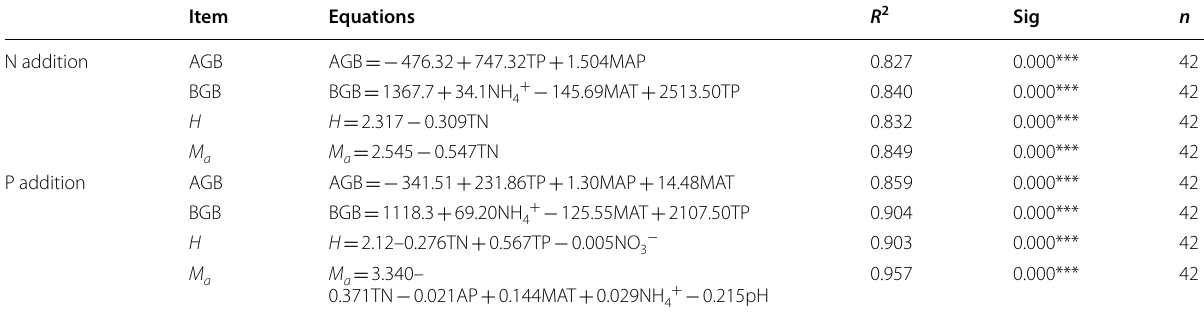
*** indicates level of significance: P <